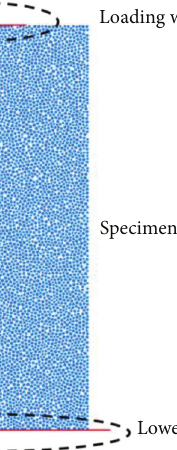
Figure 15: Schematic illustration of the numerical